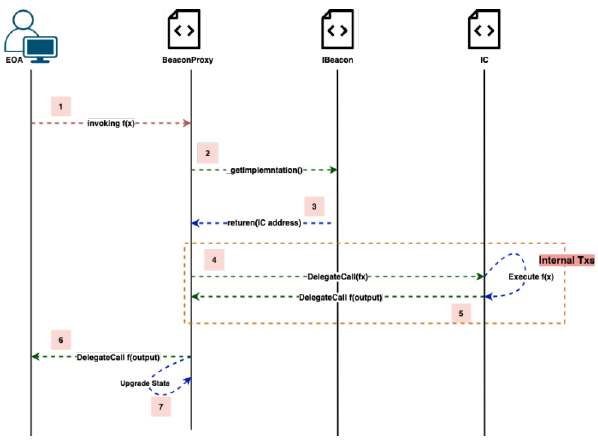
Figure 6. Process of deploying the Beacon pattern